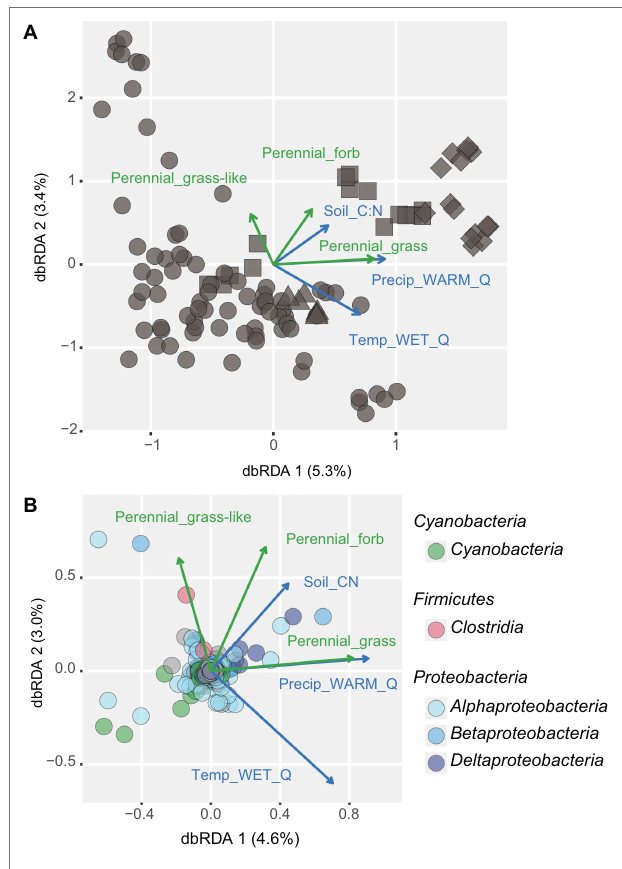
FIGURE 3 | Distance-based redundancy analysis showing (A) the variation of the diazotrophic community and (B) the OTUs of relevant taxonomic classes as a factor of different environmental parameters based on our best descriptive model. Three abiotic variables, mean temperature in the wettest quarter (Temp_WET_Q), mean precipitation in the warmest quarter (Precip_ WARM_Q), and the soil C:N ratio; and three plant cover variables, perennial grass, perennial grass-like, and perennial forb cover are depicted as blue or green vectors, respectively. Average environmental conditions per study site are listed in Supplementary Table S5 . Shapes in panel (A) denote the respective continent (circle: North America, square: Europe, diamond: Africa, triangle: Australia). In panel (B) , colored circles denote OTUs assigned to the five most read-abundant taxonomic classes potentially shaped by displayed environmental factors. OTUs of other taxonomic classes are depicted in